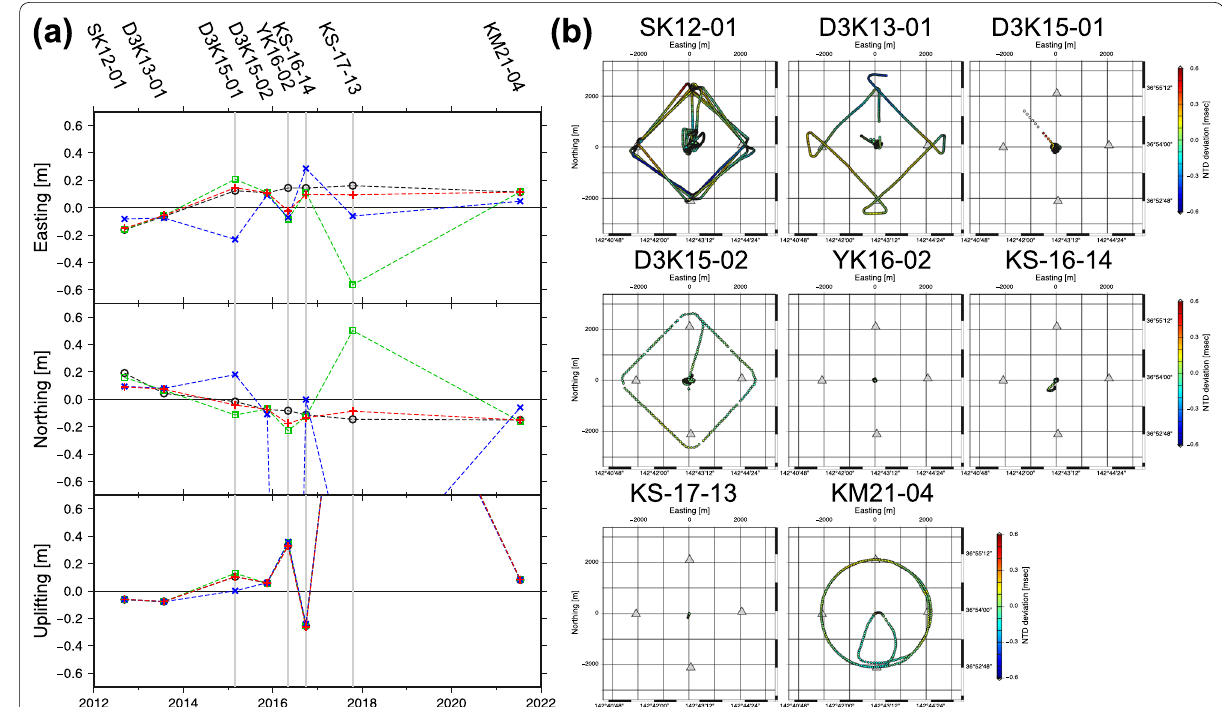
Fig. 9 Time-series of the array positions and sea-surface tracks for campaigns at G17. Each panel is described in the same manner as in Fig. 8